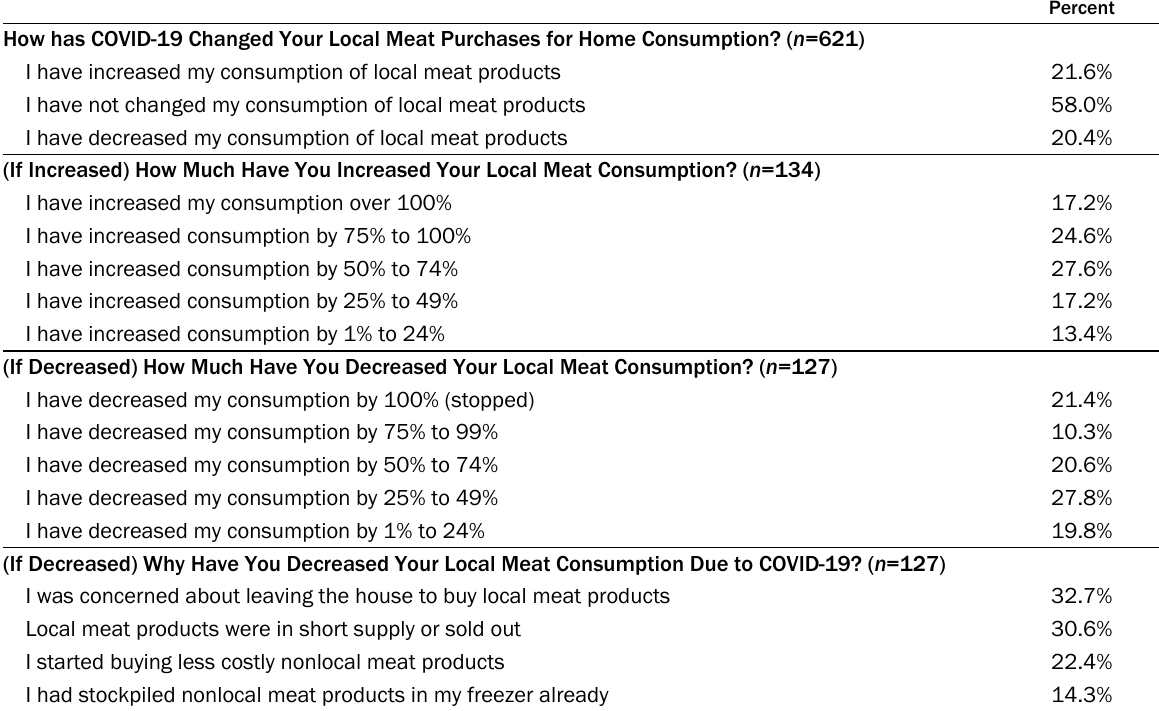
Table 1. Local Meat Purchasing Behavior at Home During